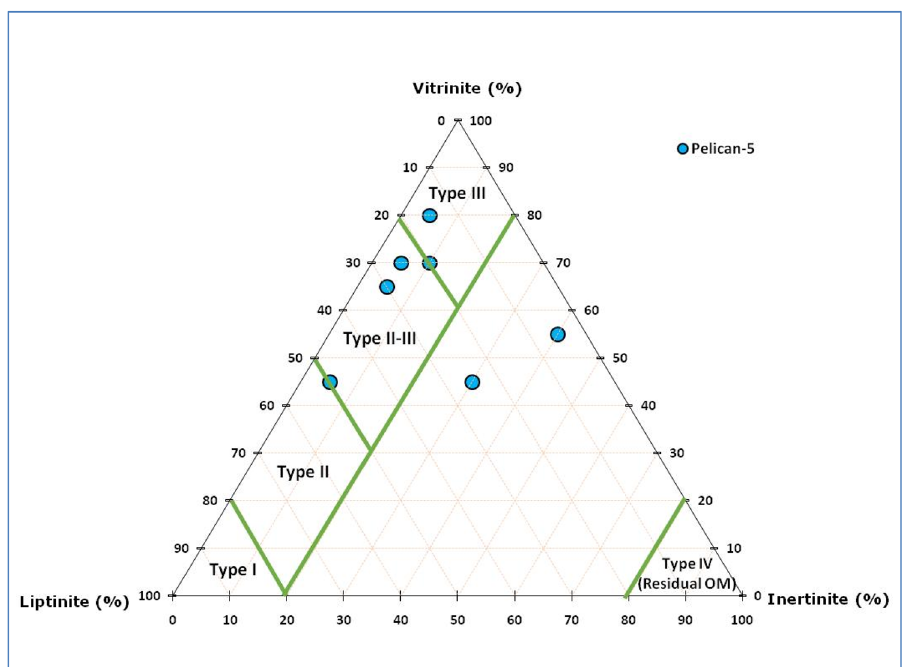
Fig. 9 Ternary diagram cor- relating concentrations of vit- rinite. Liptinite and inertinite to identify organic matter